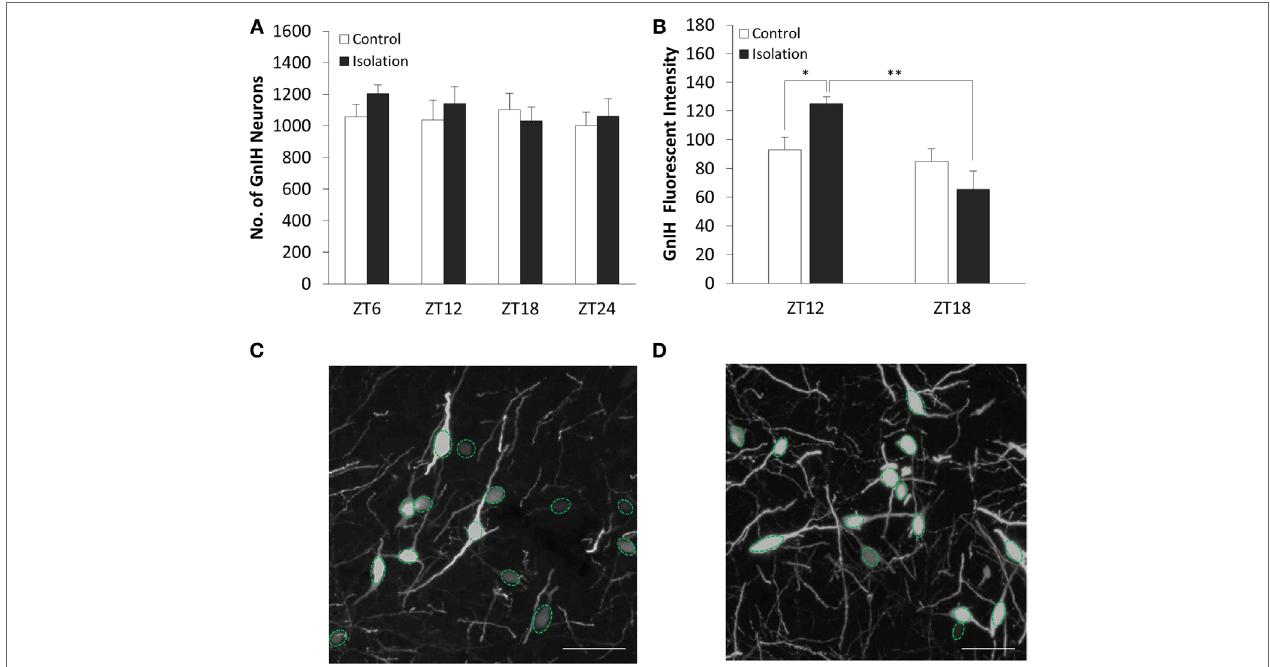
FigUre 2 | The effect of social isolation on CLOCK expression in gonadotropin-inhibitory hormone (GnIH) neurons in the dorsomedial hypothalamus (DMH) region. (a) Total GnIH cell numbers aggregated by ZT time, for control and isolated groups in the DMH (control: ZT6 n = 6, ZT12 n = 6, ZT18 n = 6, ZT24 n = 6 and isolation: ZT6 n = 6, ZT12 n = 7, ZT18 n = 8, ZT24 n = 6). (B) Average intensity of GnIH neurons of control and isolated rats at ZT12 and ZT18 (control: ZT12 n = 6, ZT18 n = 6 and isolation: ZT12 n = 6, ZT18 n = 6). (c) Image of DMH GnIH neurons at 40 × magnification for control (ZT12) and (D) isolation (ZT12). Scale bar = 50 µm (c,D)